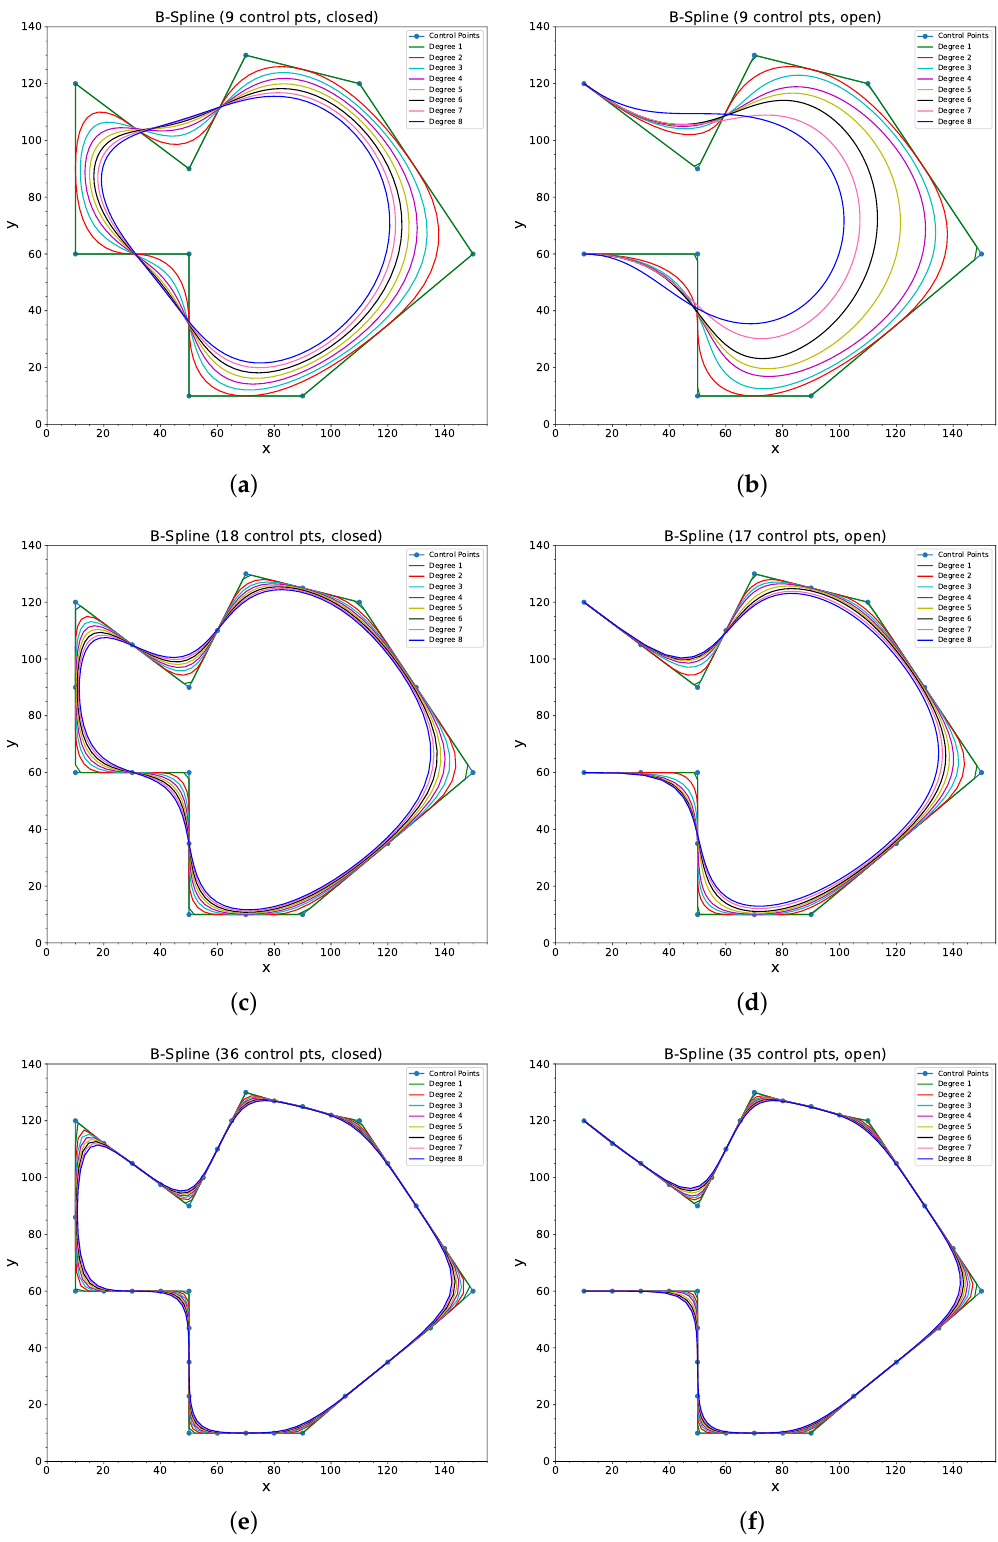
Figure 5. B-Spline-based robot path smoothing with varying number of control points and degrees. ( a , c , e ) shows closed path (robot returns to the same location) while ( b , d , f ) shows open paths. ( a ) Closed path, 9 control points. ( b ) Open path, 9 control points. ( c ) Closed path, 18 control points. ( d ) Open path, 17 control points. ( e ) Closed path, 36 control points. ( f ) Open path, 35 control